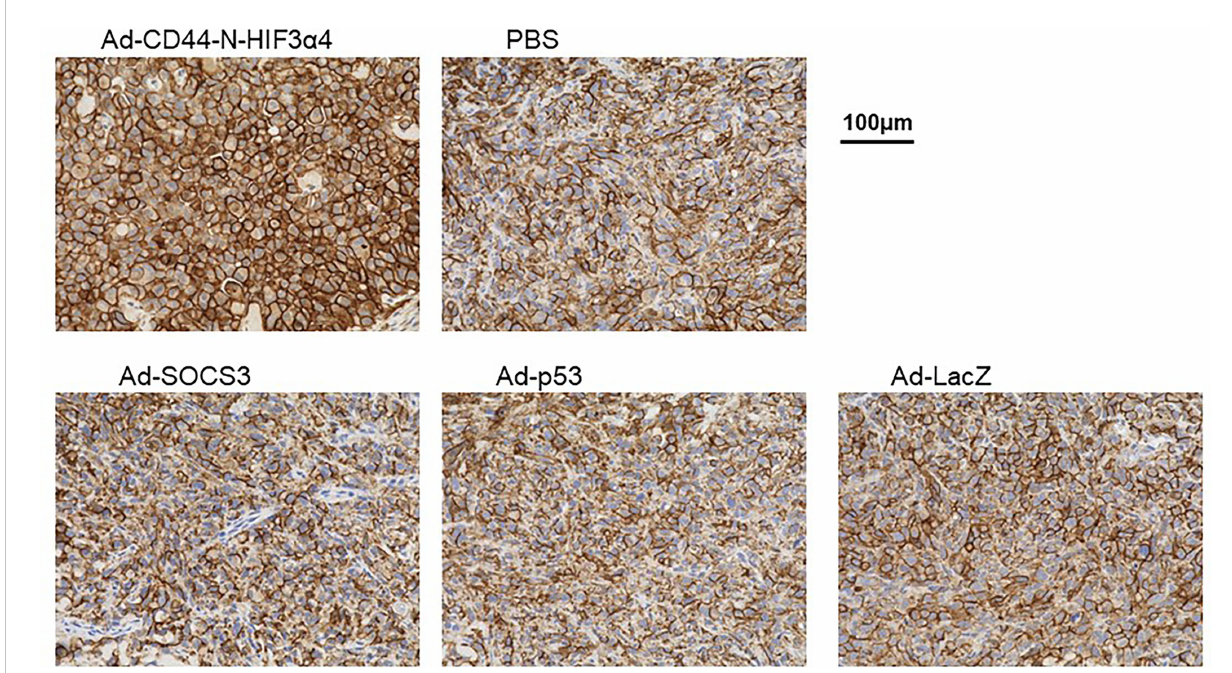
FIGURE 8 Immunohistochemical staining for CD44 in MDA-MB-231 tumor injected with adenovirus vectors One million MDA-MB-231 cells were subcutaneously inoculated into nude mice for tumor formation, followed by intratumoral injections of Ad-CD44-N-HIF3 a 4, Ad-SOCS3, Ad-p53, Ad- LacZ or PBS. After the treatments, tumors were resected and stained for CD44 expressions. The remarkably increased expression of CD44 was detected in the cell membrane of tumor injected with Ad-CD44-N-HIF3 a 4 compared to tumors injected with the other adenovirus vectors or PBS. (Original magni fi cation: